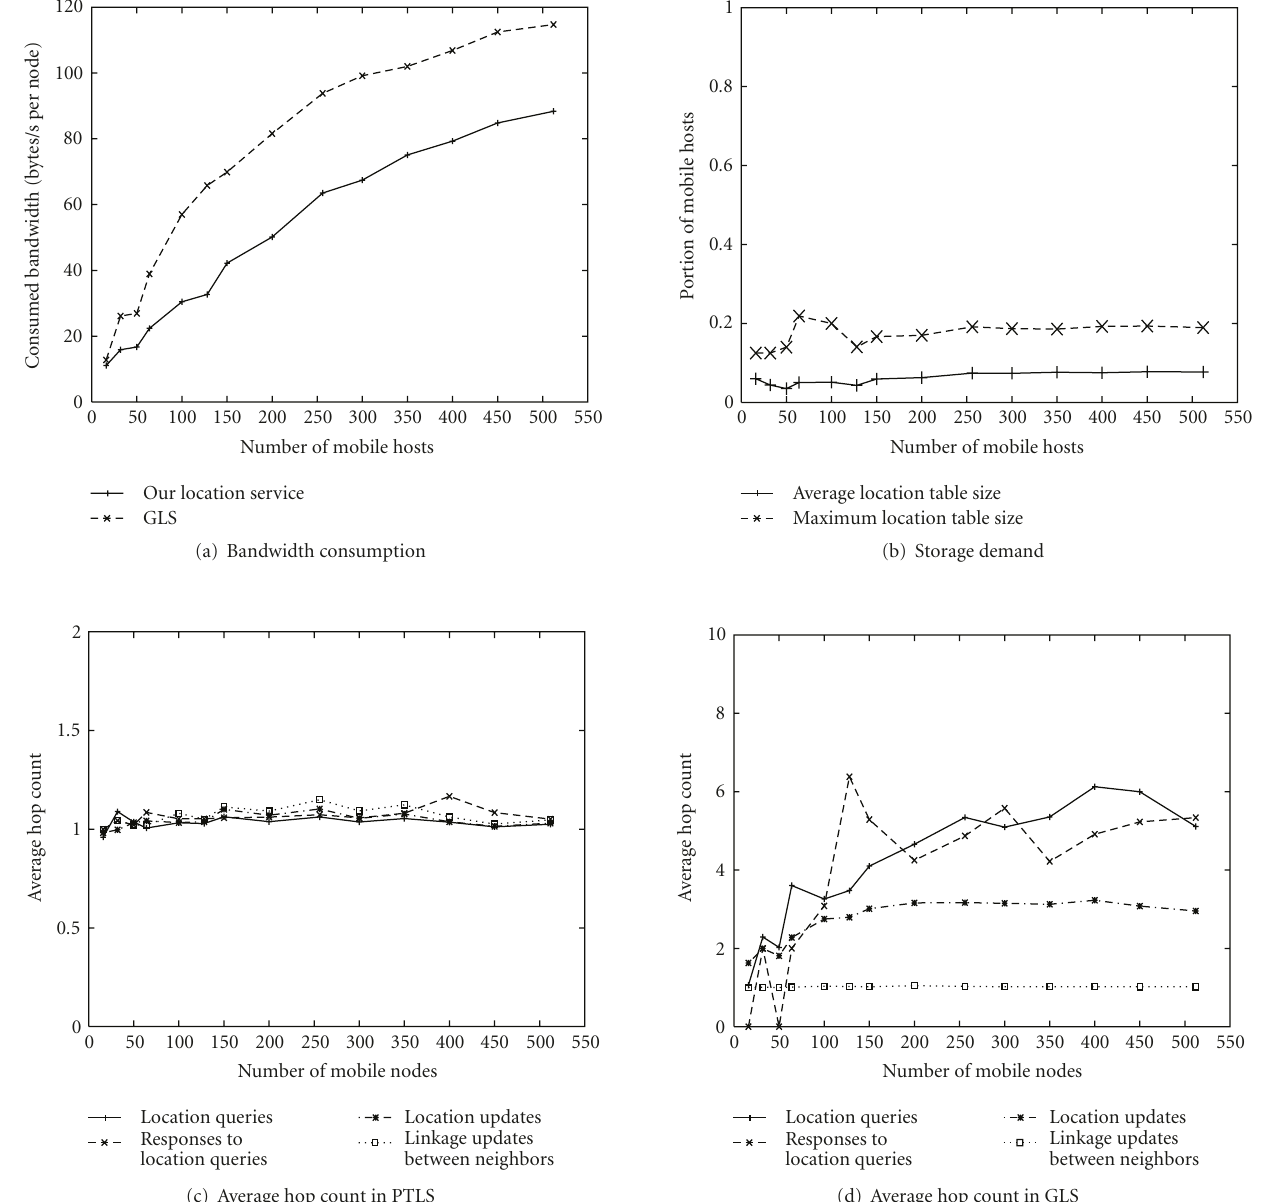
Figure 4: Comparison of the performance of the PTLS service and the GLS service under di ff erent numbers of mobile hosts. All simulations are run in a 3000 × 3000 meter 2